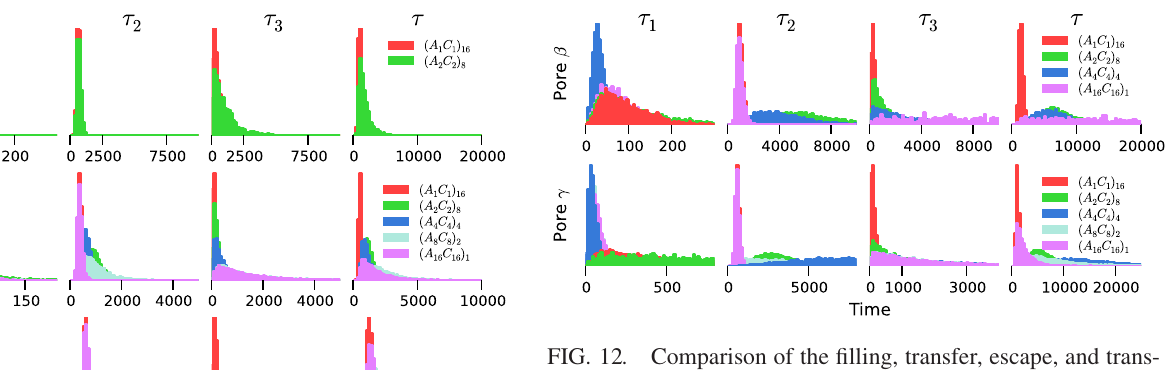
FIG. 12. Comparison of the filling, transfer, escape, and trans- location time distributions for the Pores (cid:3) and (cid:4) at F ¼ 0 : 5 and W ¼ 2 : 25 using heteropolymers with different sequences. Translocation through Pore (cid:2) is extremely slow for this range of values and is not considered for this analysis.